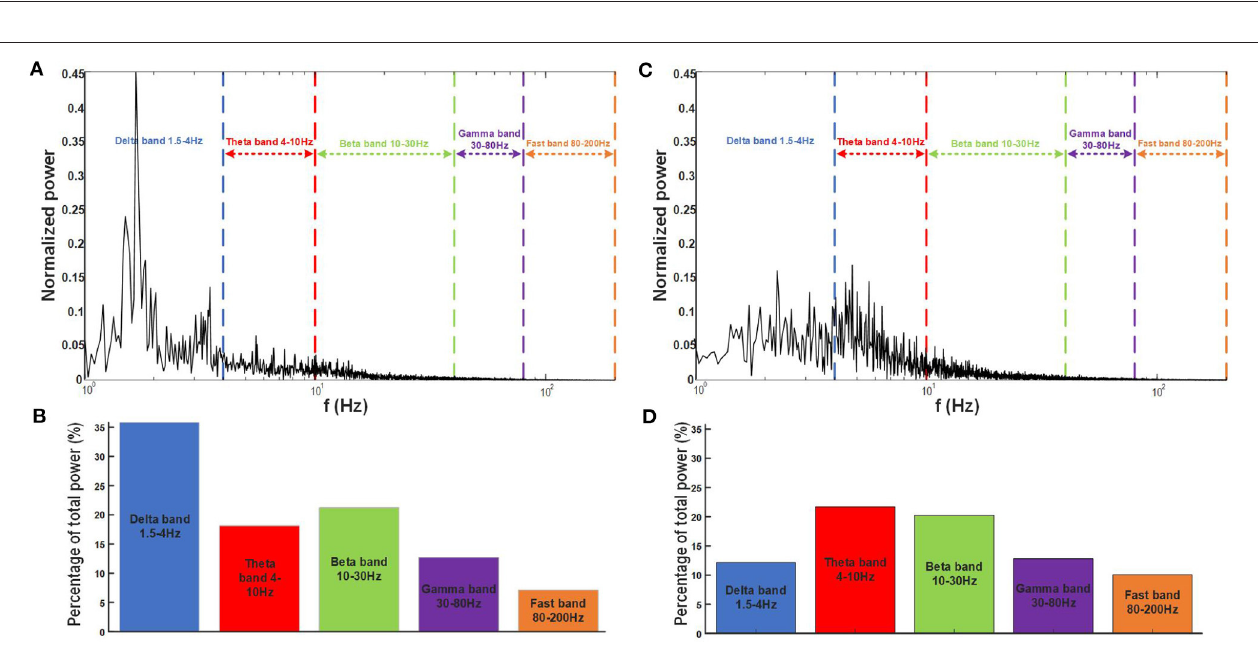
FIGURE 8 | Clustered APs detected for 16 channels recorded simultaneously during a 30 s period. The average AP for each cluster is displayed in red in order to better visualize its shape. Each AP waveform is 2.4ms.